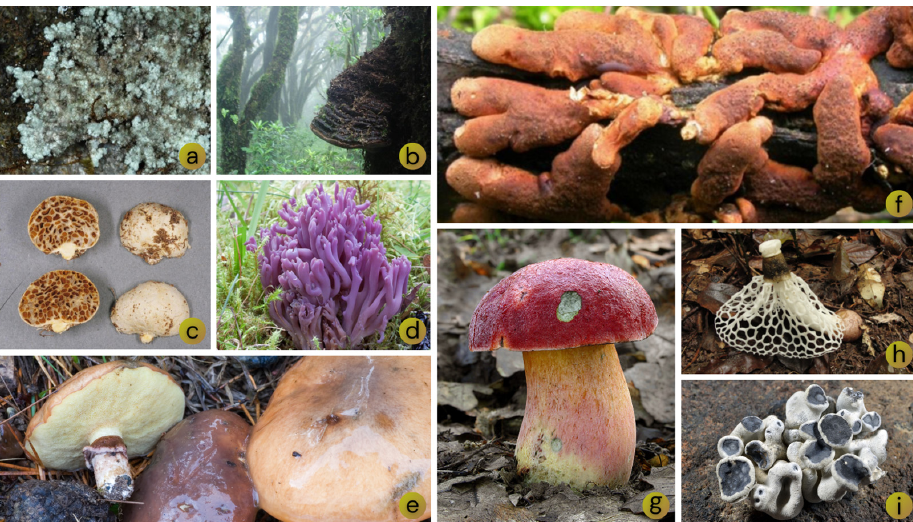
Figure 1. Remarkable fungal species assessed in the IUCN Red List: ( a ) Lepraria lanata Tønsberg assessed as EN (photo by James Lendemer); ( b ) Fomitiporia nubicola Alves-Silva, Bittencourt & Drechsler-Santos assessed as VU (photo by G. Alves-Silva); ( c ) Cortinarius crypticus (E. Horak) Soop & B. Oertel assessed as DD (photo by Ross Beever, Manaaki Whenua); ( d ) Clavaria zollingeri Lév. assessed as VU (photo by Michael Krikorev); ( e ) Suillus luteus (L.) Roussel assessed as LC (photo by Michael Krikorev); ( f ) Hypocreopsis amplectens T.W. May & P.R. Johnst. assessed as CR (photo by Tom May); ( g ) Rubroboletus dupainii (Boud.) Kuan Zhao & Zhu L. Yang assessed as NT (photo by Vladimír Kunca); ( h ) Phallus aureolatus L. Trierveiler-Pereira & A.A.R. de Meijer assessed as VU (photo by J.M. Baltazar); (i ) Mobergia calculiformis (W.A. Weber) H. Mayrhofer & Sheard assessed as EN (photo by Frank Bungartz).